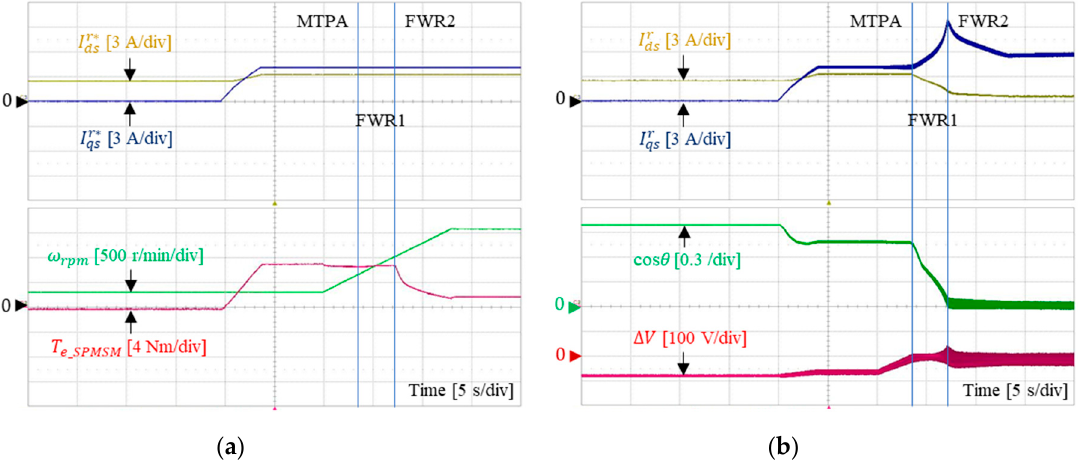
Figure 14. Experimental results with the dynamic inductance of the cross-coupled flux saturation model: ( a ) MTPA current reference and experimental conditions and ( b ) operation of the proposed algorithm.